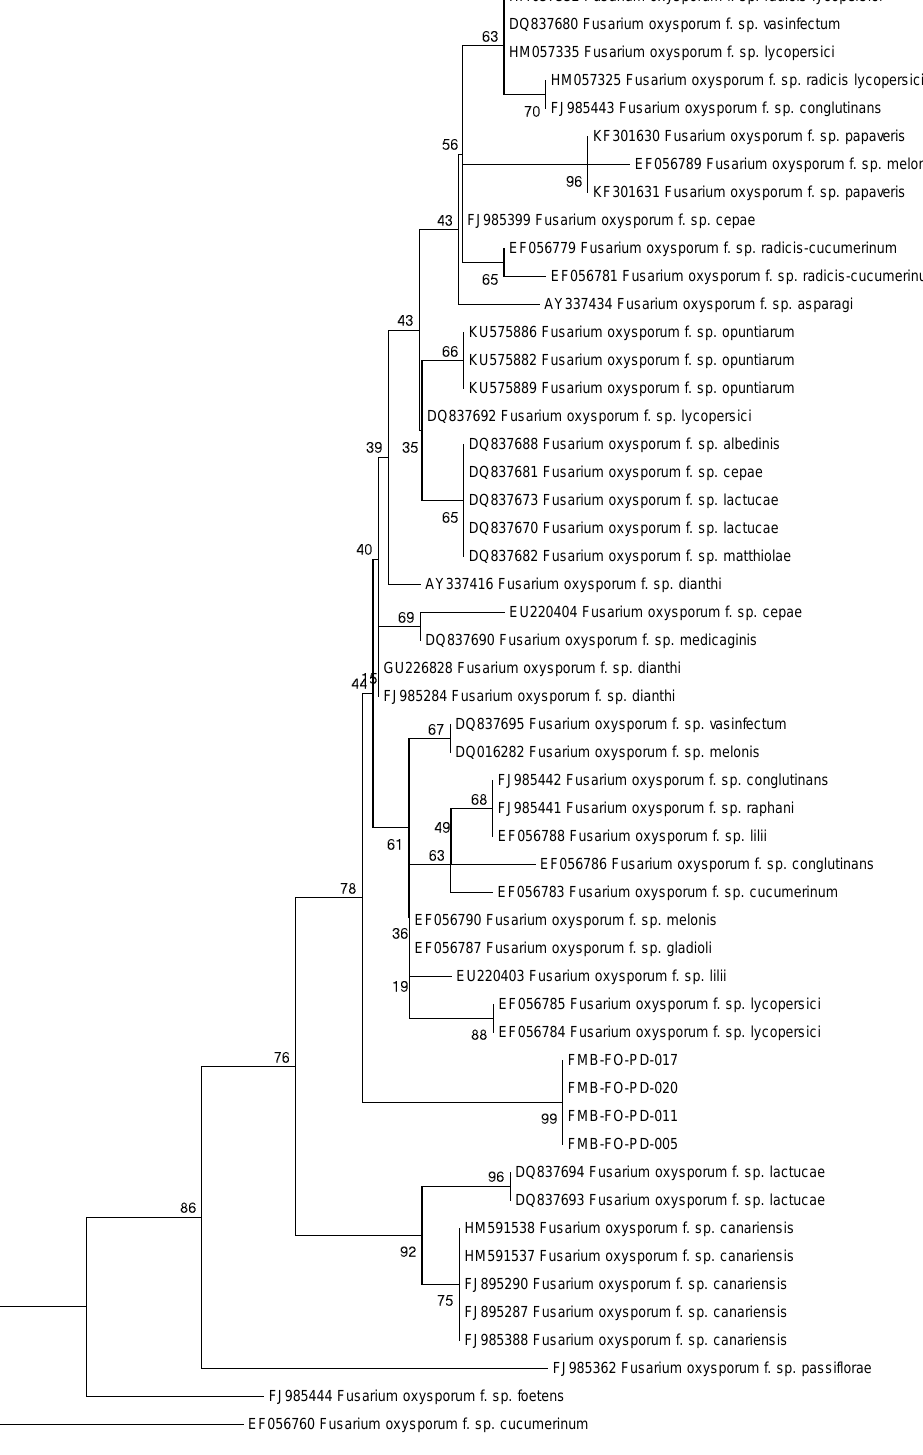
Figure 5. Phylogenetic tree based on translation elongation factor 1- α (TEF1- α ) region, using MEGA6.06 software under Neighbor-Joining (NJ) analysis, displayed a distinct and separate clade of the F. oxysporum isolates from other forma specialis with 99% bootstrap support.